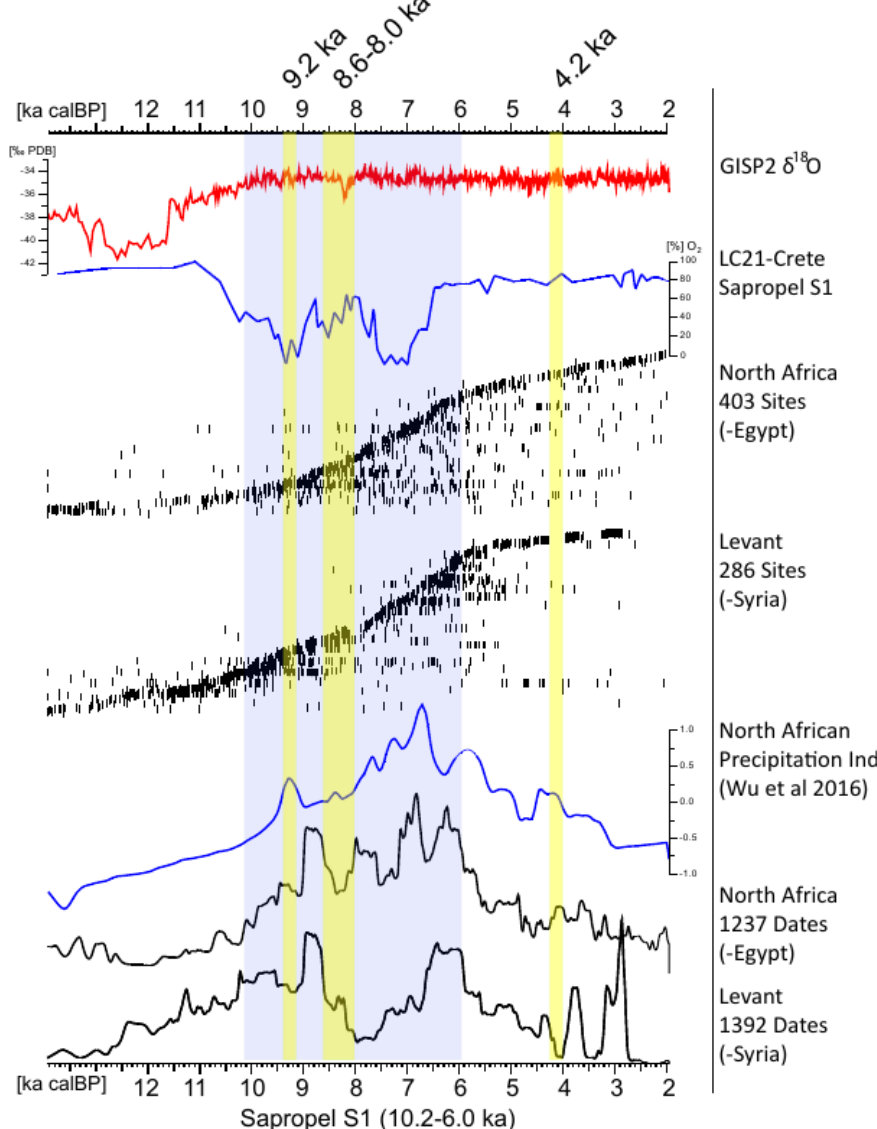
Figure 15. Comparison of Epipaleolithic and Neolithic (14C-based) Demography between the Levante (without Syria) and North Africa (without Egypt). The results of Barcode Seriation are compared with Summed Calibrated Probability Distributions of the same data. Interpretation: (1) in both regions, the demographic development is strongly dependent on water availability; (2) Neolithic (farming) demography is more sensitive to climatic extremes (RCC = rapid climate change) than Epipaleolithic (hunting/gathering). (North African Precipitation Index data from